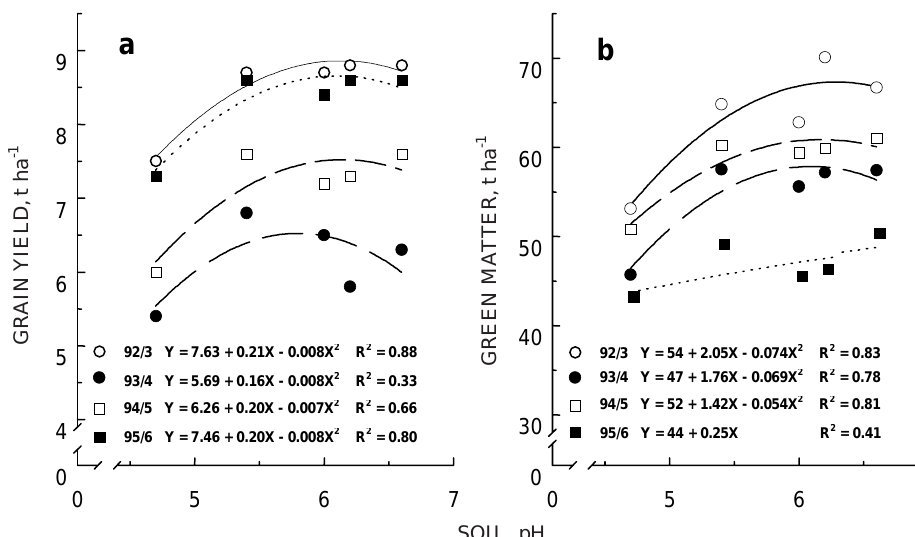
Figure 1. Corn grain yield (a) and corn green matter yield for silage (b)in four consecutive growing seasons, as affected by addition of dolomitic limestone rates in an Oxisol, in Lages, Southern Brazil. Average of four